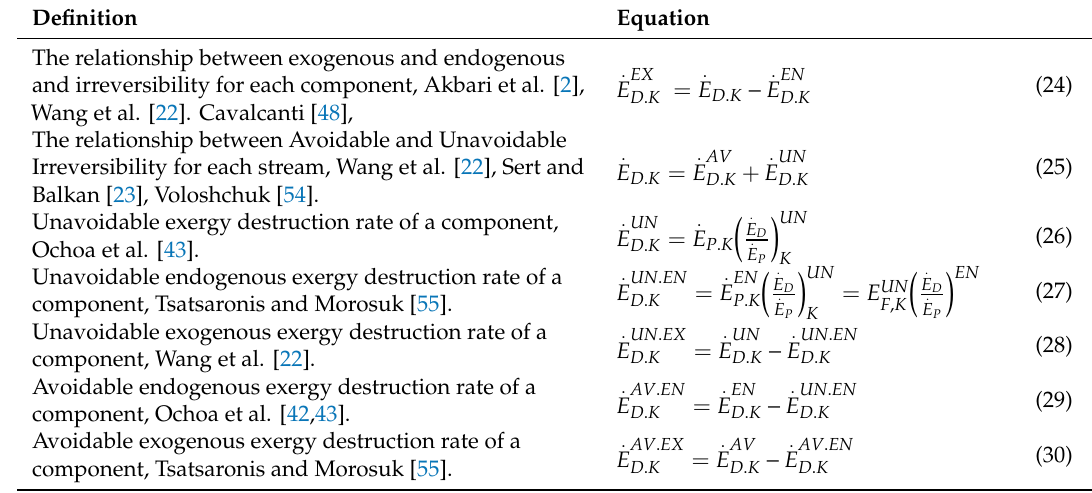
Table 5. Equations for the advanced exergy